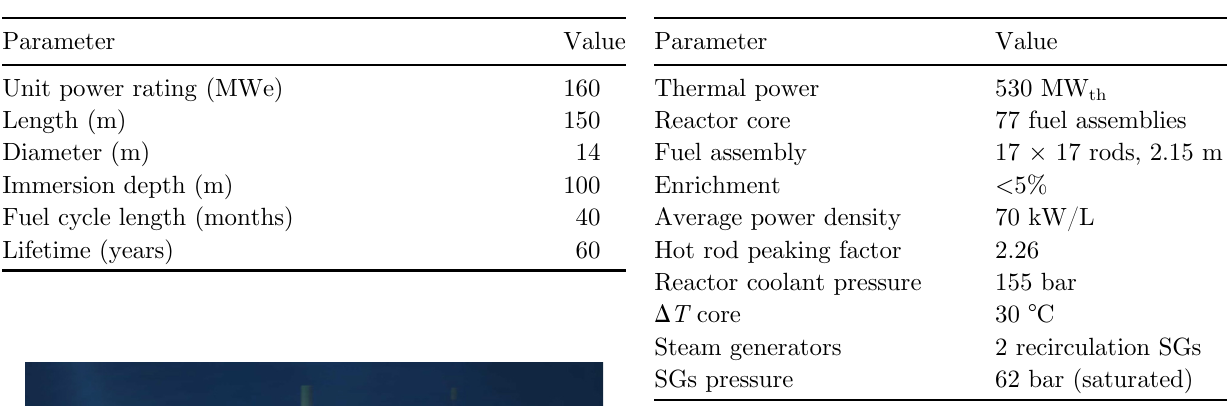
Table 1. Flexblue ® module main characteristics.